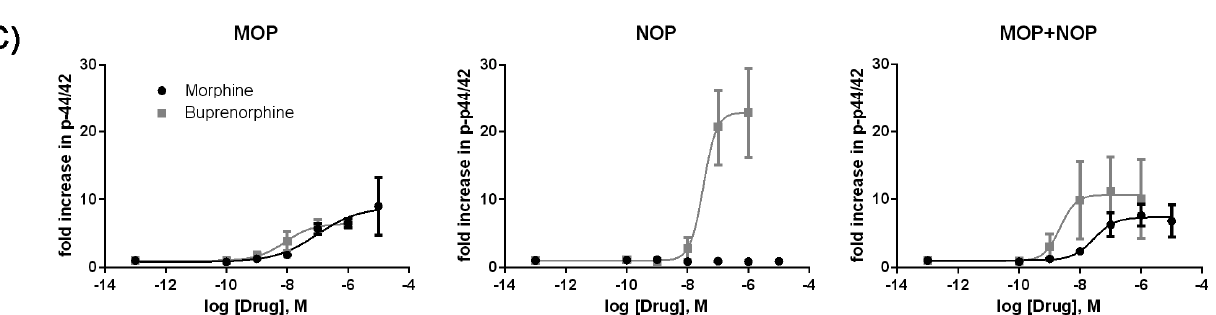
Figure 4. Representative immunoblots of Erk1/2 (p44/p42 MAPK) phosphorylation after stimulation with ( A ) morphine and ( B ) buprenorphine in cells stably expressing MOP, NOP, and MOP+NOP receptors. Immunoblotting using anti-phospho-p44/p42 MAPK (Erk1/2) rabbit polyclonal and anti- p44/42 MAPK (Erk1/2) rabbit monoclonal antibodies was performed to visualize opioid-induced phosphorylation of Erk1/2 (p44 MAPK-P and p42 MAPK-P) and total Erk1/2 (p44 MAPK and p42 MAPK), respectively. ( C ) Dose–response curves of the immunoblots. The density of phospho- p44/p42 MAPK versus the density of p44/42 MAPK in control cells (with vehicle treatment) was considered to be 1. All the experiments were repeated no less than four times, and the values represent the average ± SE.